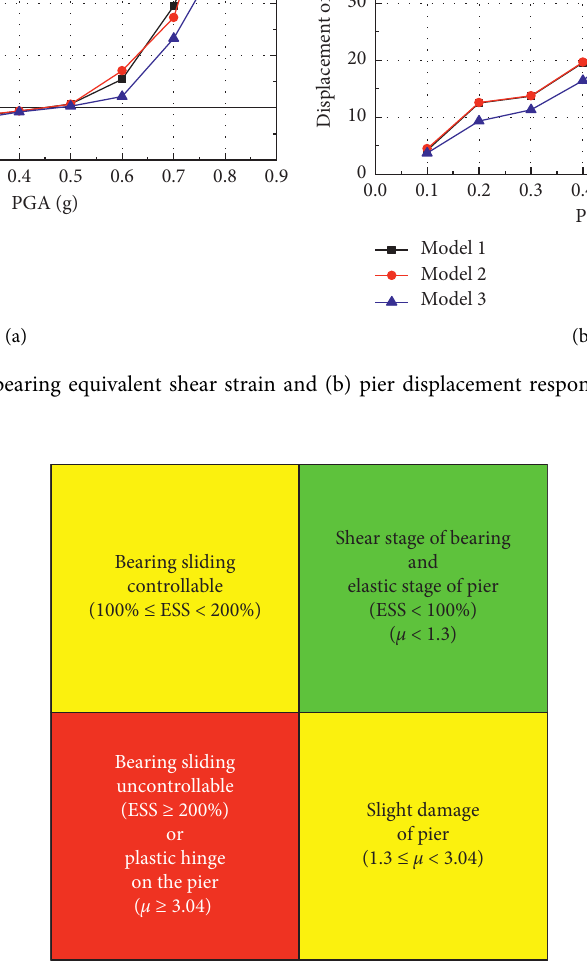
Figure 11: The seismic damage criteria of the bridge.